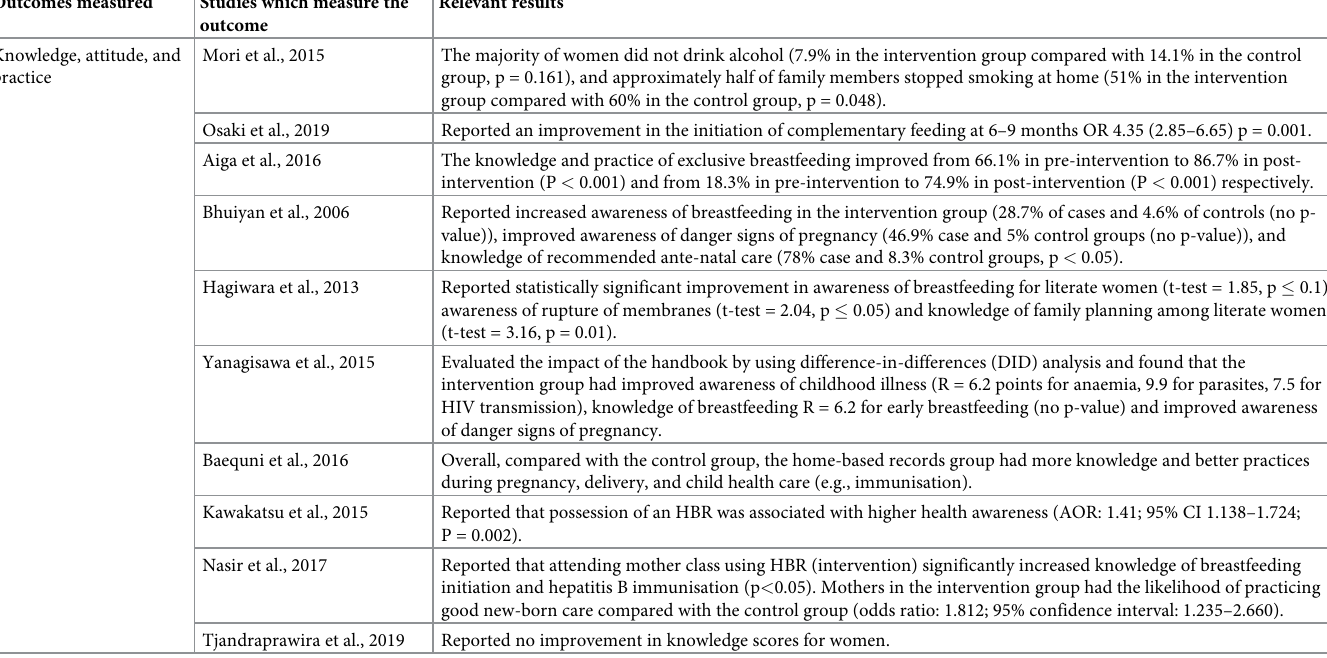
Table 5. Handover communication tool from HCPs to